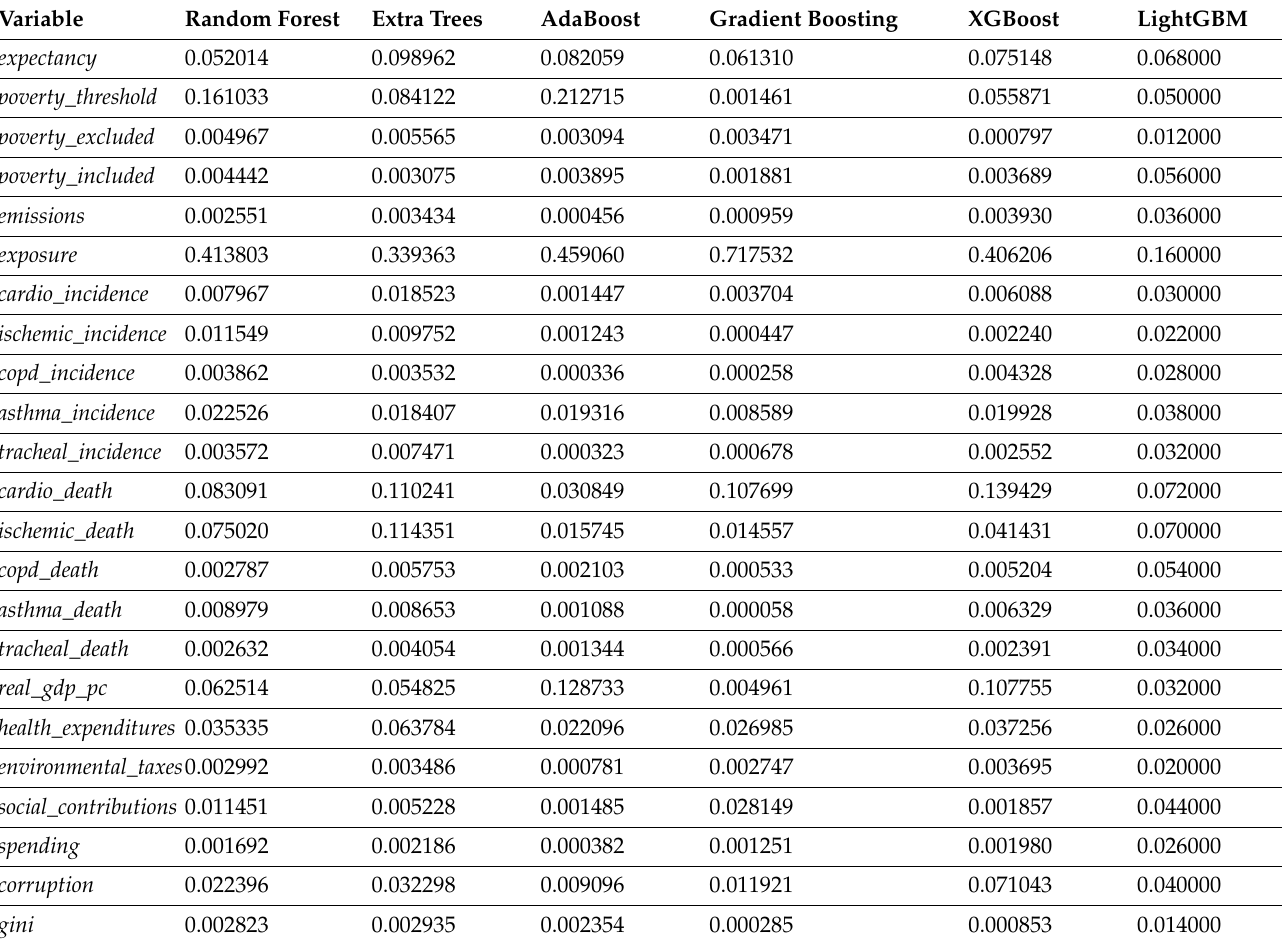
Table 2. Feature importances for all supervised machine learning